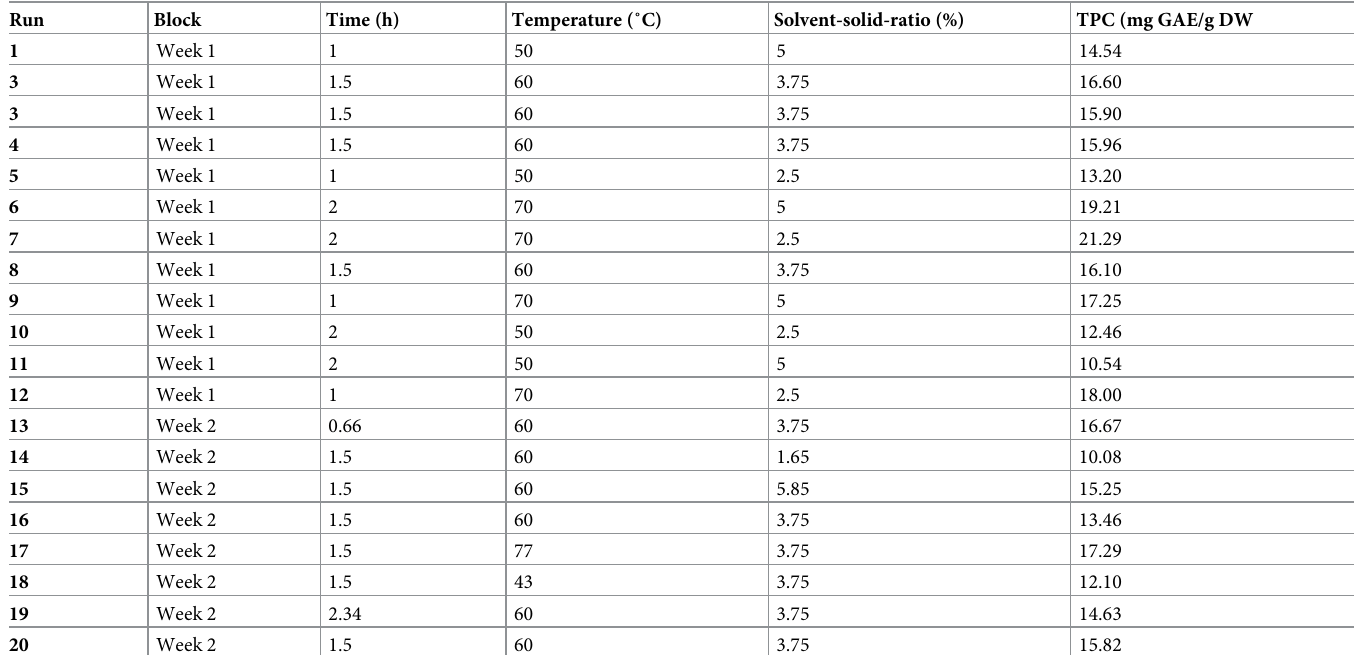
Table 2. The experimental factors and the actual value.